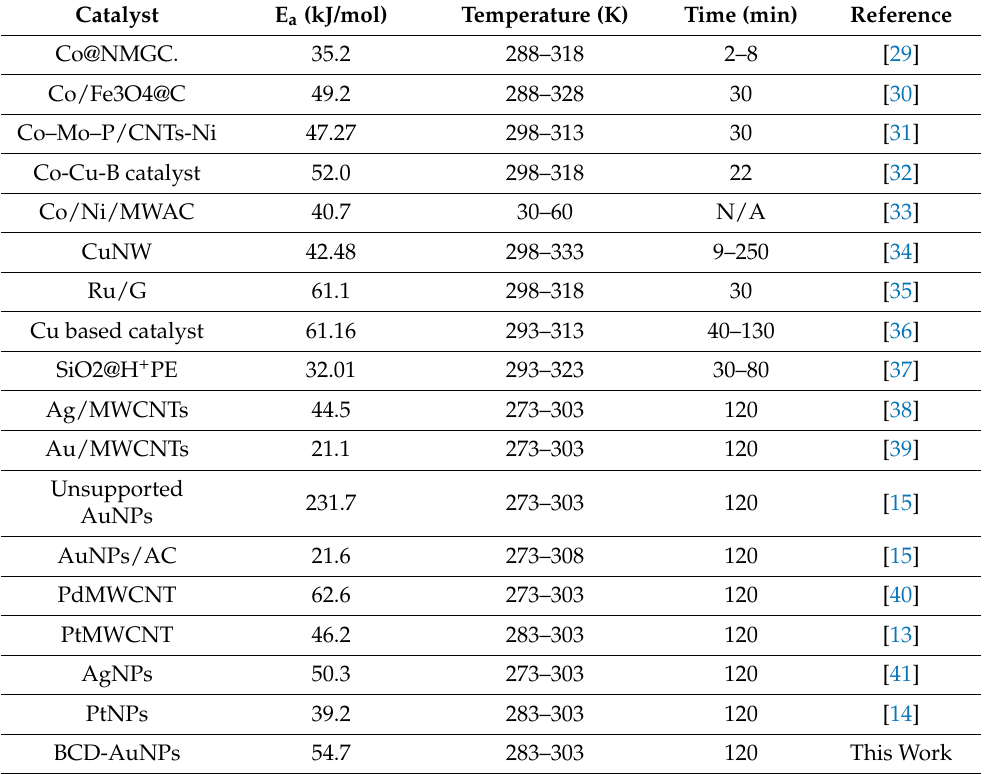
Figure 8. Volume of hydrogen gas generated by the hydrolysis of NaBH 4 versus time as catalyzed by the BCD − AuNPs at 283 K, 288 K, 295 K, and 303 K. The reactions were run at pH 7 with 925 µ moles of NaBH 4 for 120 min. Table 1. Reported activation energies for NaBH 4 hydrolysis by